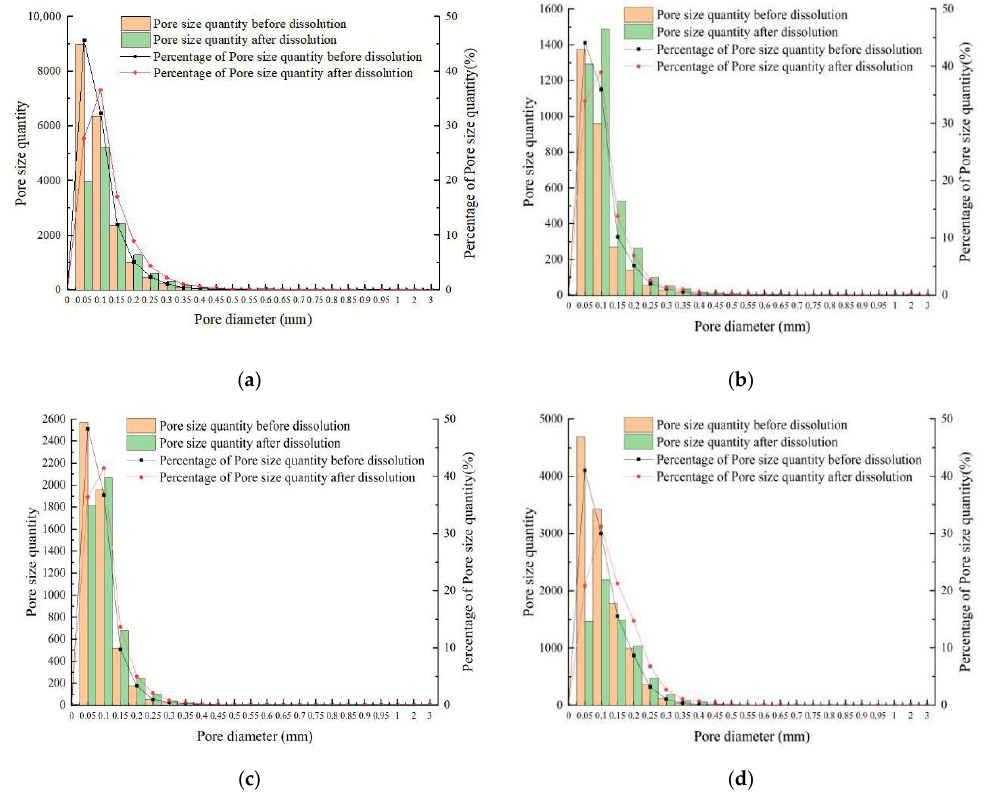
Figure 10. Relationship between pore number and the corresponding pore percentage for different pore diameters: ( a ) sample 5#; ( b ) sample 6#; ( c ) sample 7#; ( d ) sample